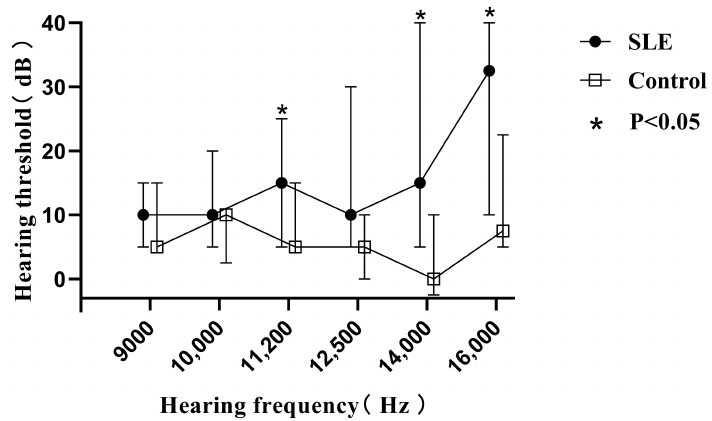
Figure 2. Comparison of extended high frequency audiometry thresholds at 9000 to 16,000 Hz between SLE patients (38 ears) and controls (16 ears) with normal pure tone audiometry thresholds. Data are presented as median and interquartile range, and the median values at each hearing frequency are linked by the trend line. * p < 0.05 by Mann–Whitney U Test.